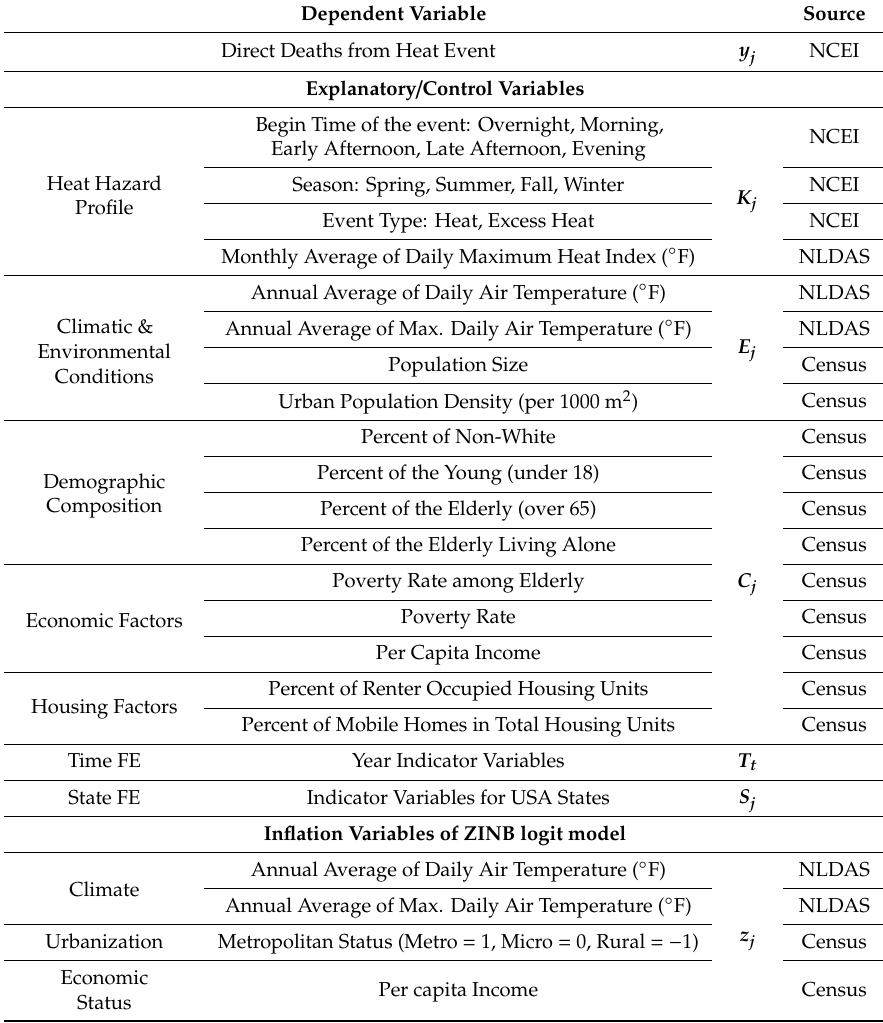
Table 4. List of variables in the heat fatality